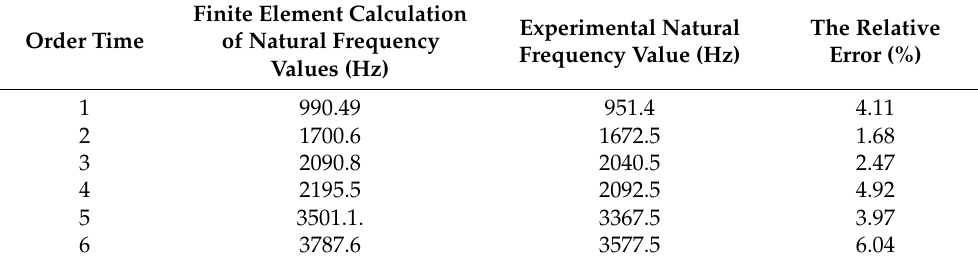
Figure 15. Experimental results of the dynamic performance of the micro-drive reduction mechanism. Table 2. Comparison between the finite element method and experimental dynamic